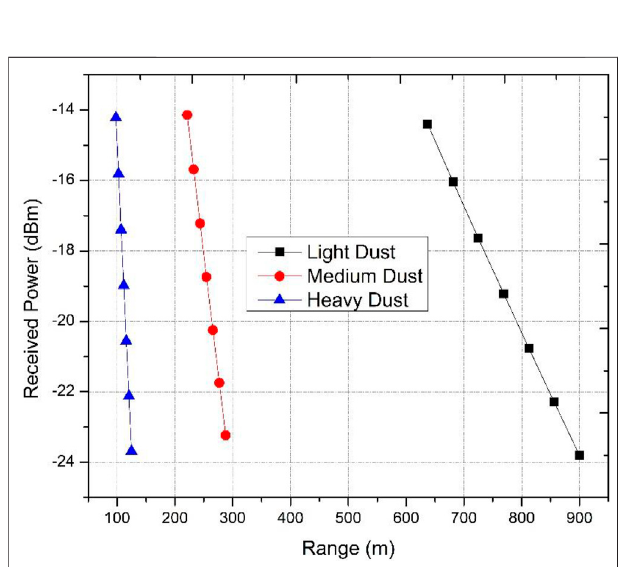
FIGURE10| log(BER) vs. range under dust stormconditions forOFDM/ SAC-OCDMA-FSO.